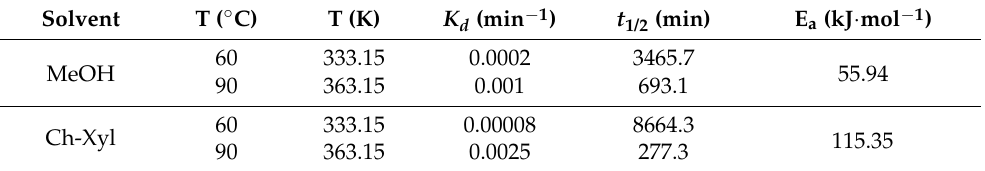
Table 6. Degradation constant ( K d ) and half-life ( t 1/2 ) values for anthocyanins extracted from